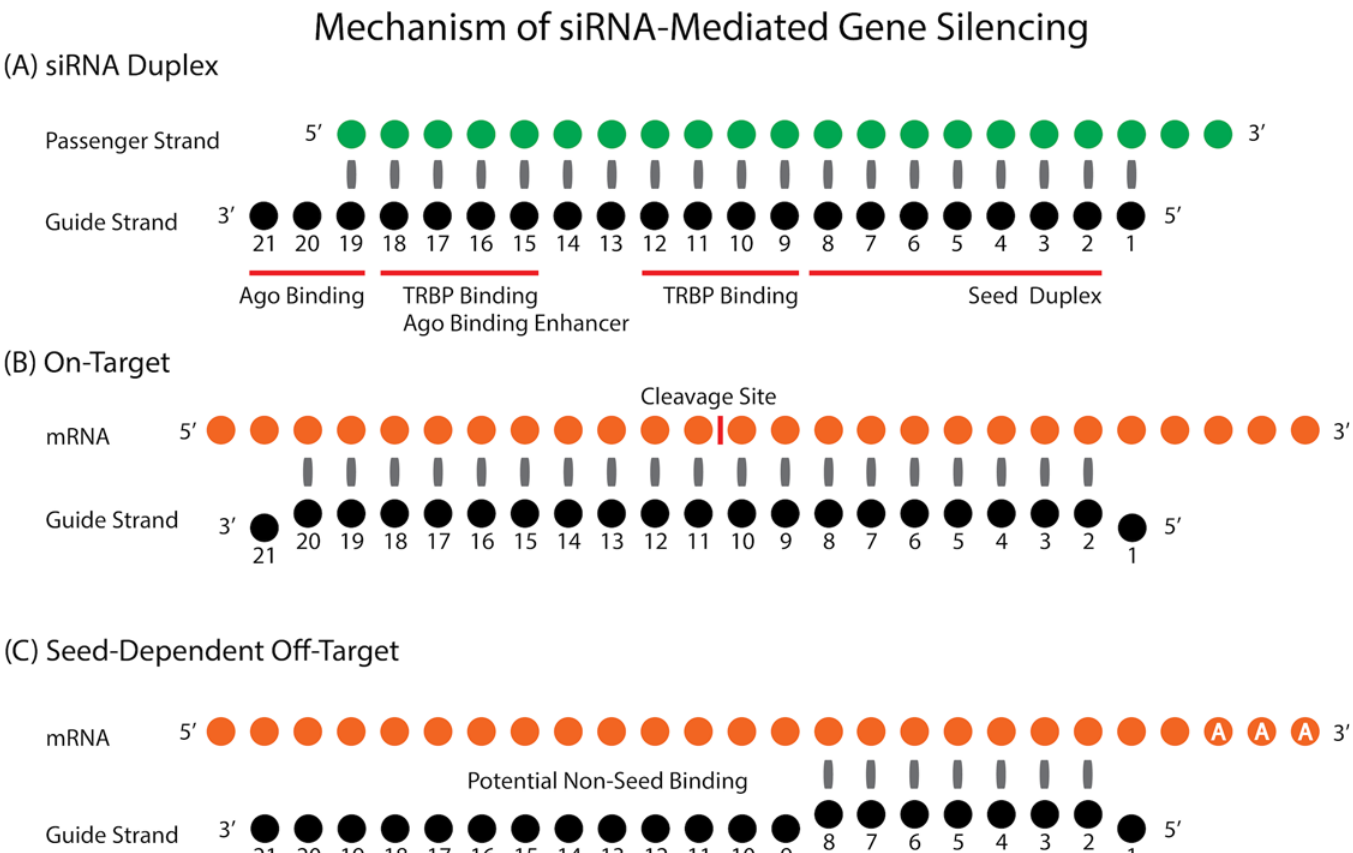
Fig 1. Graphical representation of siRNA molecule. (A) siRNA duplex with presumed binding sites for RISC proteins, Ago and TRBP [6]. (B) Interaction pattern between siRNA guide strand and on-target transcript and (C) interaction between siRNA guide strand and its seed-dependent off-target transcript. The mechanistic overview shows the guide strand of siRNA (A) as the strand which enters RISC, and acts in downstream silencing events (B and C). Nucleotide position numbers mirror those used in the text and consequent